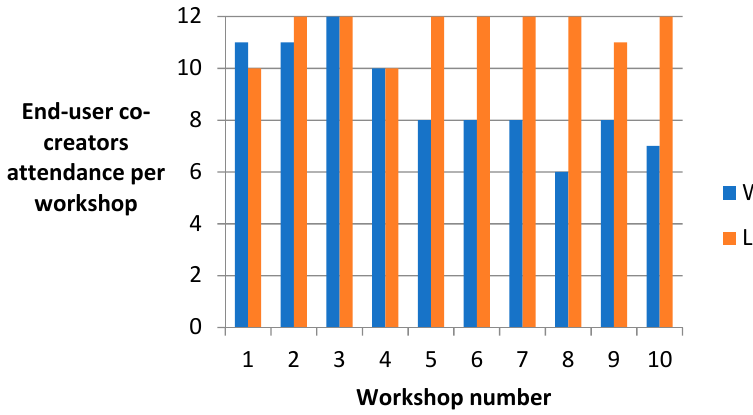
Figure 1. Attendance rates of end-user co-creators.